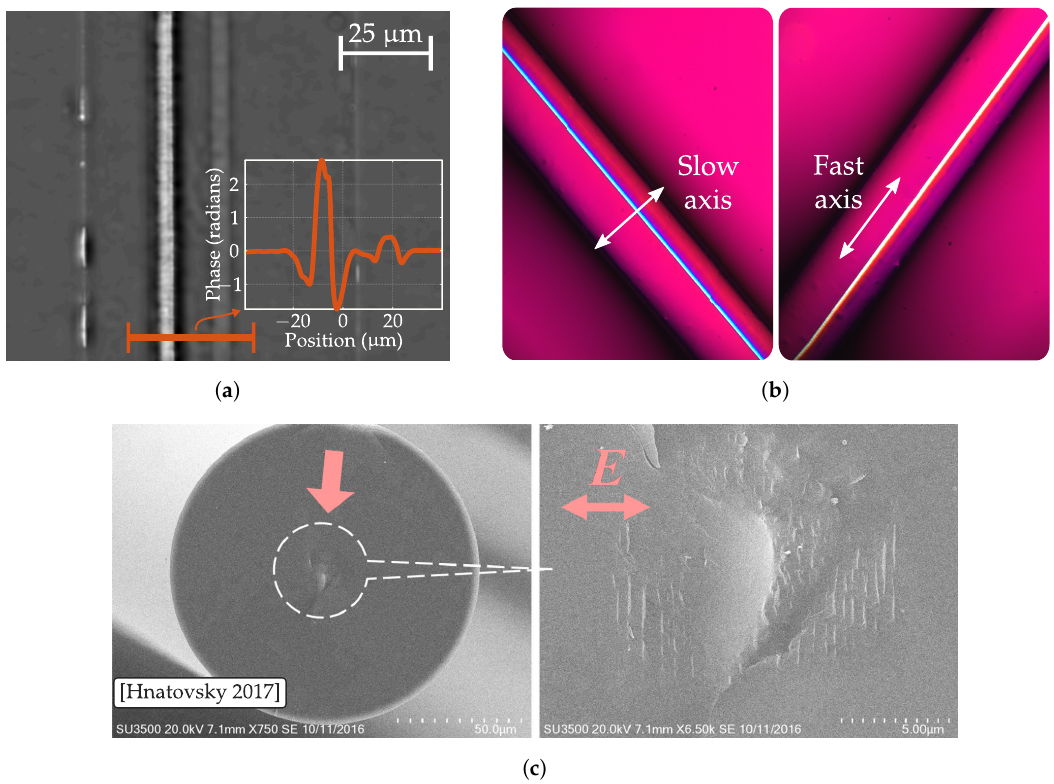
Figure 1. ( a ) Quantitative phase microscopy (QPM) image of an optical fiber inscribed by a femtosecond laser focused 35 µ m bellow fiber surface. There is a strong positive Type I stress related modification at core level. Inscription parameters: NA = 0.5, λ = 1030 nm, E p = 1.09 µ J, τ = 370 fs, PRR = 120 kHz, and v = 10 µ m/s. ( b ) Transmission optical microscope images of an inscribed optical fiber in an arrangement with a fullwave retarder. The color change reveals the existence of slow and fast axis in the inscribed region; thus, implying birefringence. ( c ) SEM images of a SMF-28 fiber with Type II modifications at core, left figure shows the fiber cross-section and right figure magnifies the core region (adapted with permission from [40], ©The Optical